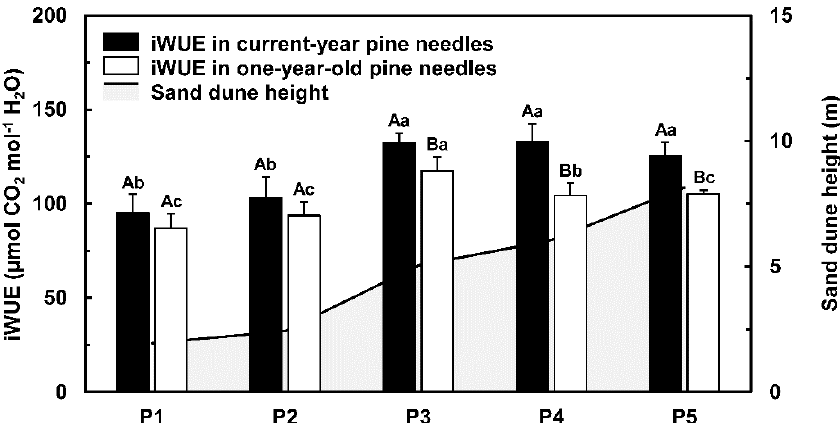
Figure 5. Comparison of iWUE values in Mongolian pine needles according to changes in sand dune height. Values with different capital letters indicate significant differences between two needle age classes in each measurement point according (Mann-Whitney test, p ≤ 0.05). Values with different small letters denote significant differences among five measurement points in each needle age class (Jonckheere–Terpstra test, p ≤ 0.05).